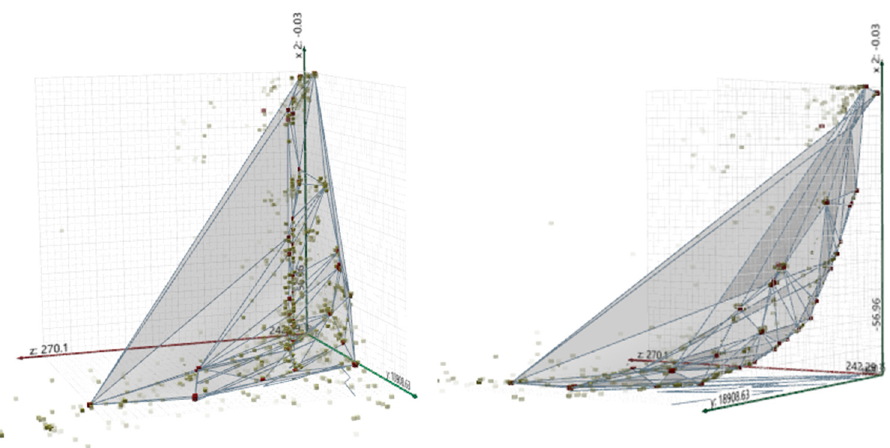
Figure 4. Non-dominated